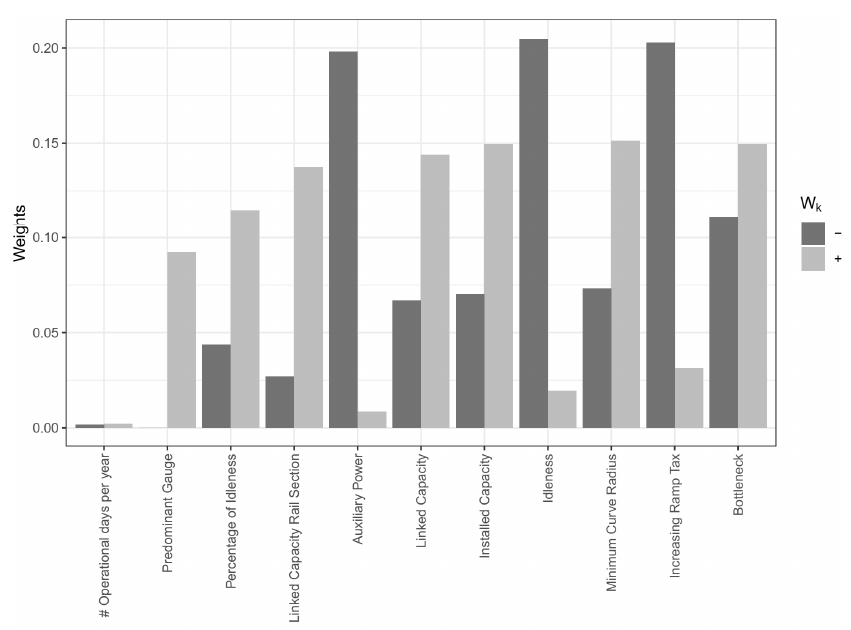
Figure 5. Positive and negative weights for each normalized attribute.